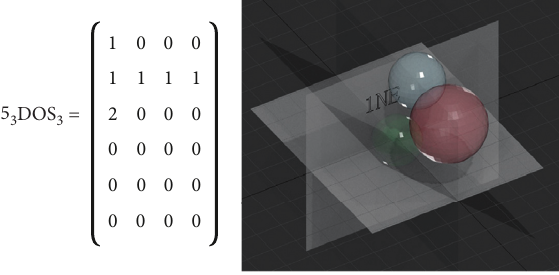
Figure 18: R5 3 DOS-intersection model in Example